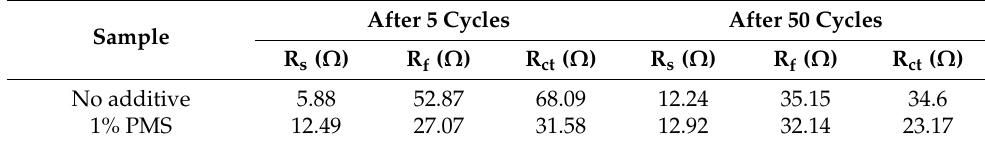
Table 2. EIS fitting results of the Li/graphite half-cells using electrolytes without and with 1 wt% PMS after 5 cycles 0.5 C as formation and 50 cycles 1 C .